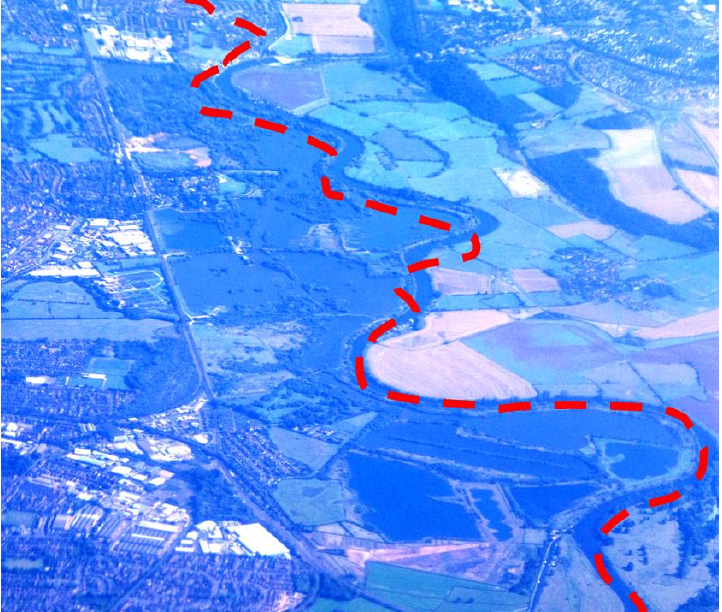
Figure 2b: Aerial photo next to Manchester, United Kingdom: The river line is still natural today (marked red broken line), which is illustrat- ing the drawing before in the similar real